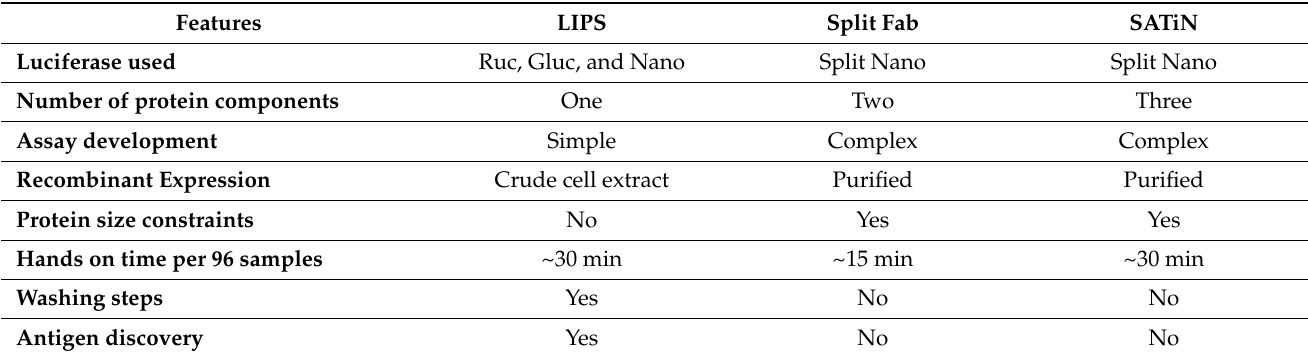
Table 3. Advantages and Disadvantages of LIPS and Split Luciferase